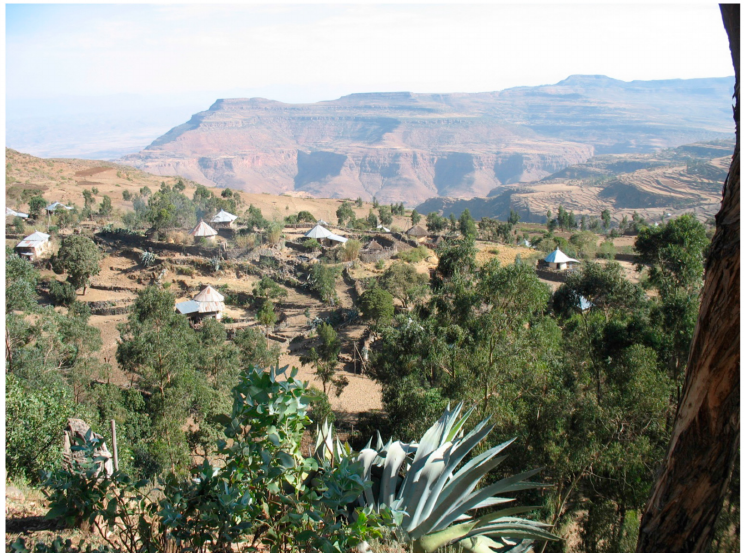
Figure 1. Landscape picture of part of the study area in Hagare Selam. Pointed tin roofs approxi- mately represent one household. Stone bunds are visible between households and, in the back of the picture, in the fields (Photo: Å.